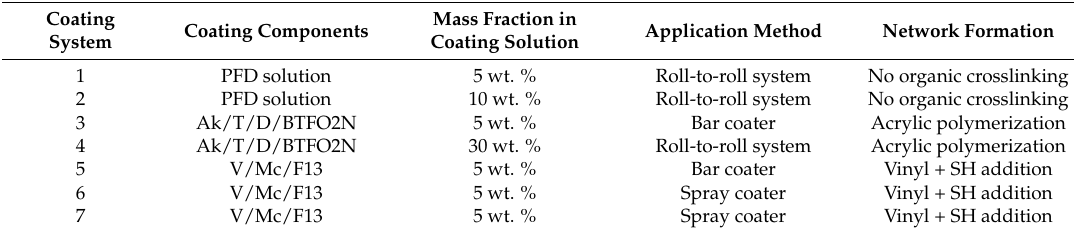
Table 1. Composition of the coatings used in this study (perfluorodecyl: PFD; the second